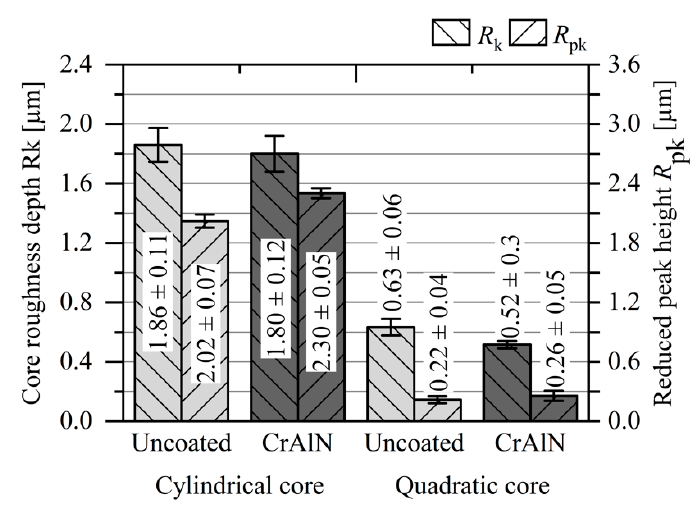
Figure 13. Core roughness depth R k and reduced peak height R pk of uncoated and post-treated CrAlN coated cores.